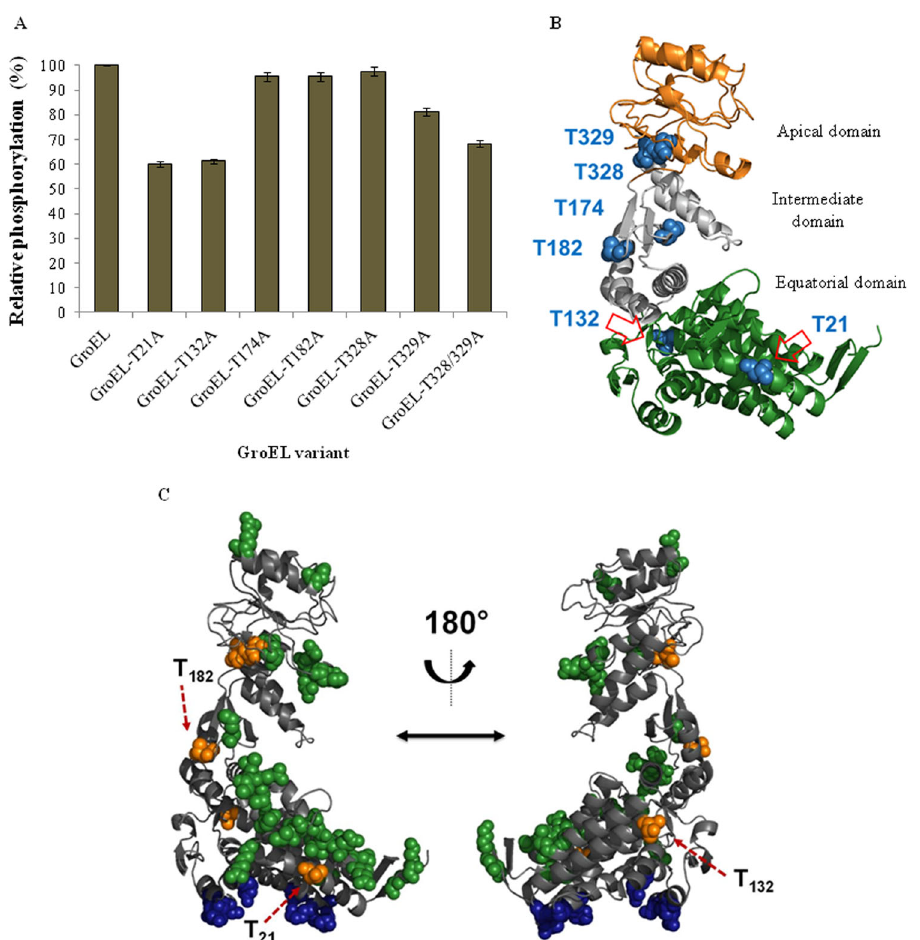
Fig. 6 Structural localization of GroEL phosphorylation sites: a To understand the contribution of individual phosphorylation sites in GroEL, non-phosphorylatable mutants (Thr to Ala) were generated and were used for in vitro kinase assays with PrkC c . The band intensities on autoradiogram were estimated by QuantityOne (BioRad). Phosphorylation signal on native GroEL band was taken as 100% and relative phosphorylation was calculated in the remaining samples. The experiment was performed thrice and the error bars indicate the SE of three independent values. As clearly evident, major loss in phosphorylation was observed in GroEL-T21A, GroEL-T132A, and GroEL-T328/329A. b The structural model of GroEL was generated by Modeller v9.13 using the co-ordinates from E. coli GroEL structure (PDB code: 1AON chain A). The diagrammatic representation depicts three distinct regions in GroEL: apical ( gold ), intermediate ( silver ), and equatorial ( green ). The fi gures were generated in Pymol 1.3. Phosphorylated threonine residues are indicated as spheres in blue . The six phosphorylation sites have been marked in the respective regions. c Molecular model depicting the three-dimensional structure of B. anthracis GroEL monomer. The phosphothreonine residues ( broken red arrows ) possibly involved in multimerization have been marked. Molecular visualizations were performed using the Pymol Molecular Graphics System